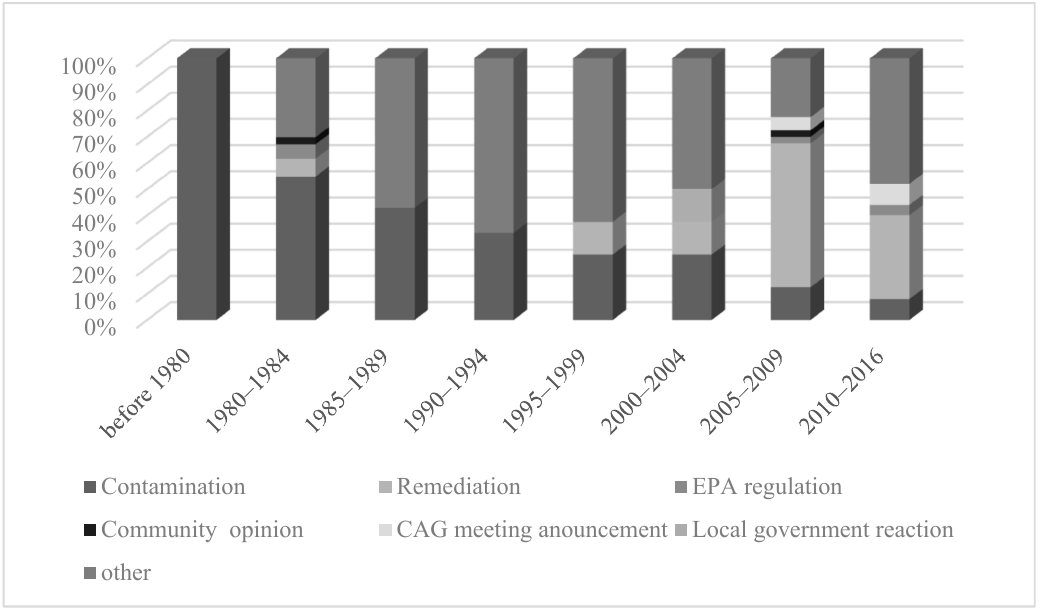
Figure 4. Over-time change in major themes in news coverage.